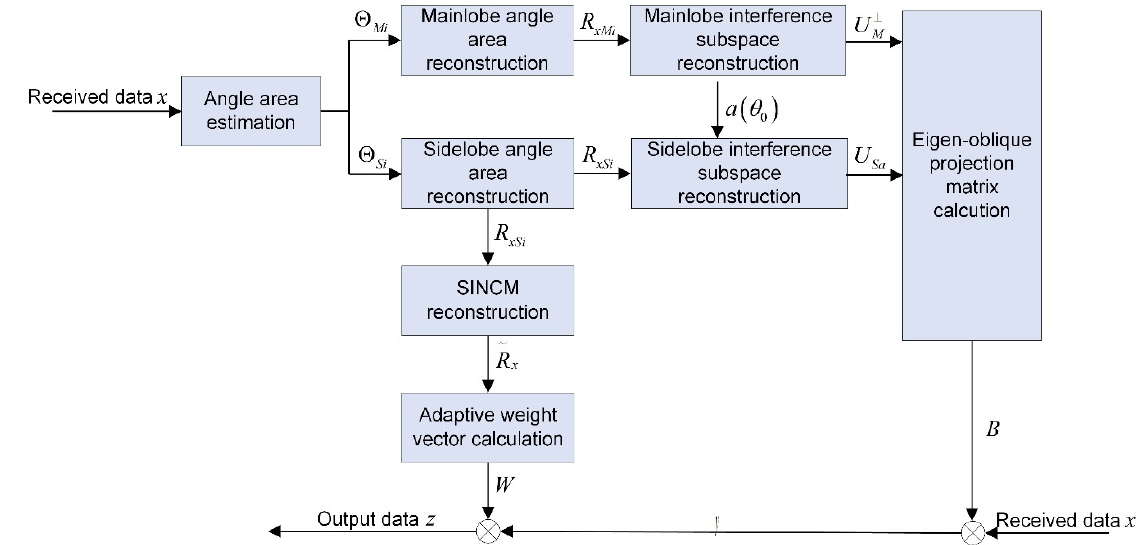
Figure 1. Processing diagram of the proposed method.